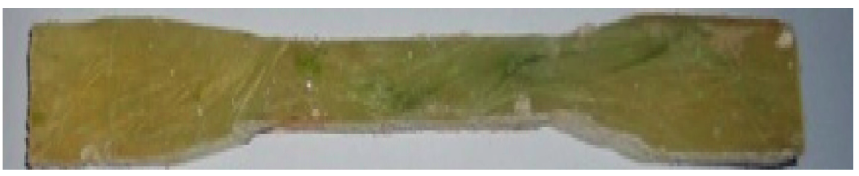
Figure 8: Specimen for tensile